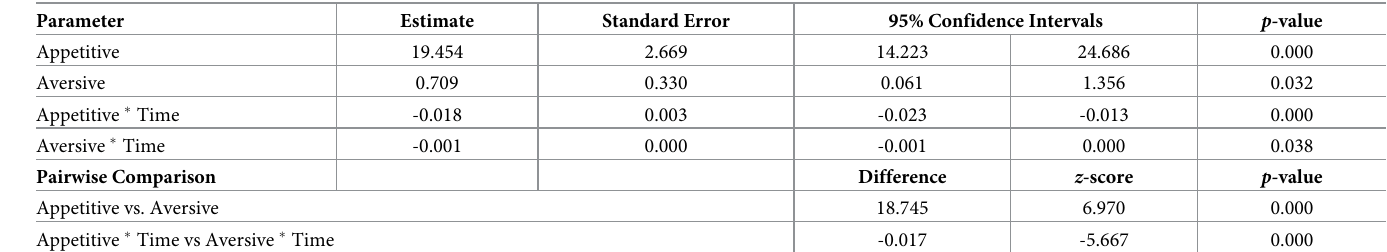
Table 7. Experiment 2 preference MPR